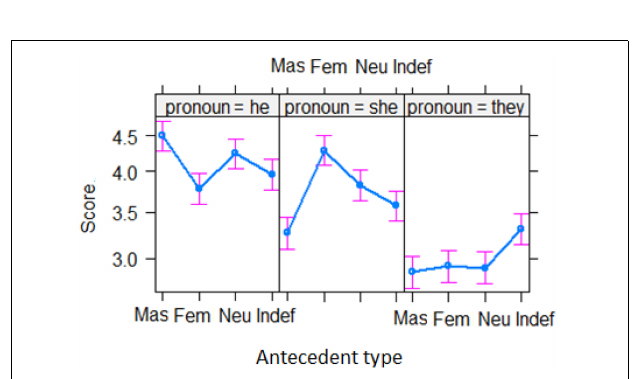
FIGURE 5 | The interaction between group and antecedent. ( Eng , English majors; Non , non-English majors; Native , native English speakers; Mas , masculine; Fem , feminine; Neu , neutral; Indef ,